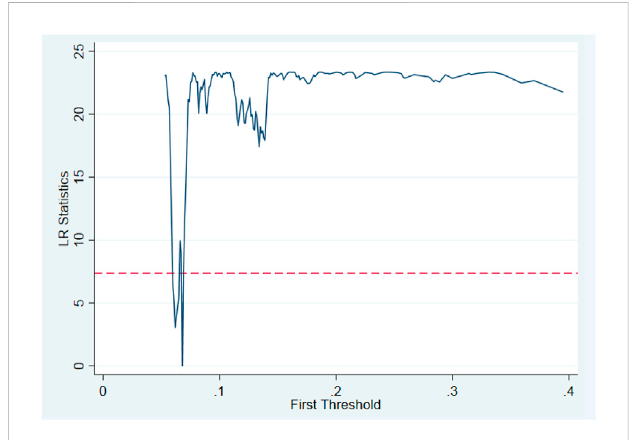
FIGURE 4 Threshold value LR diagram of energy consumption